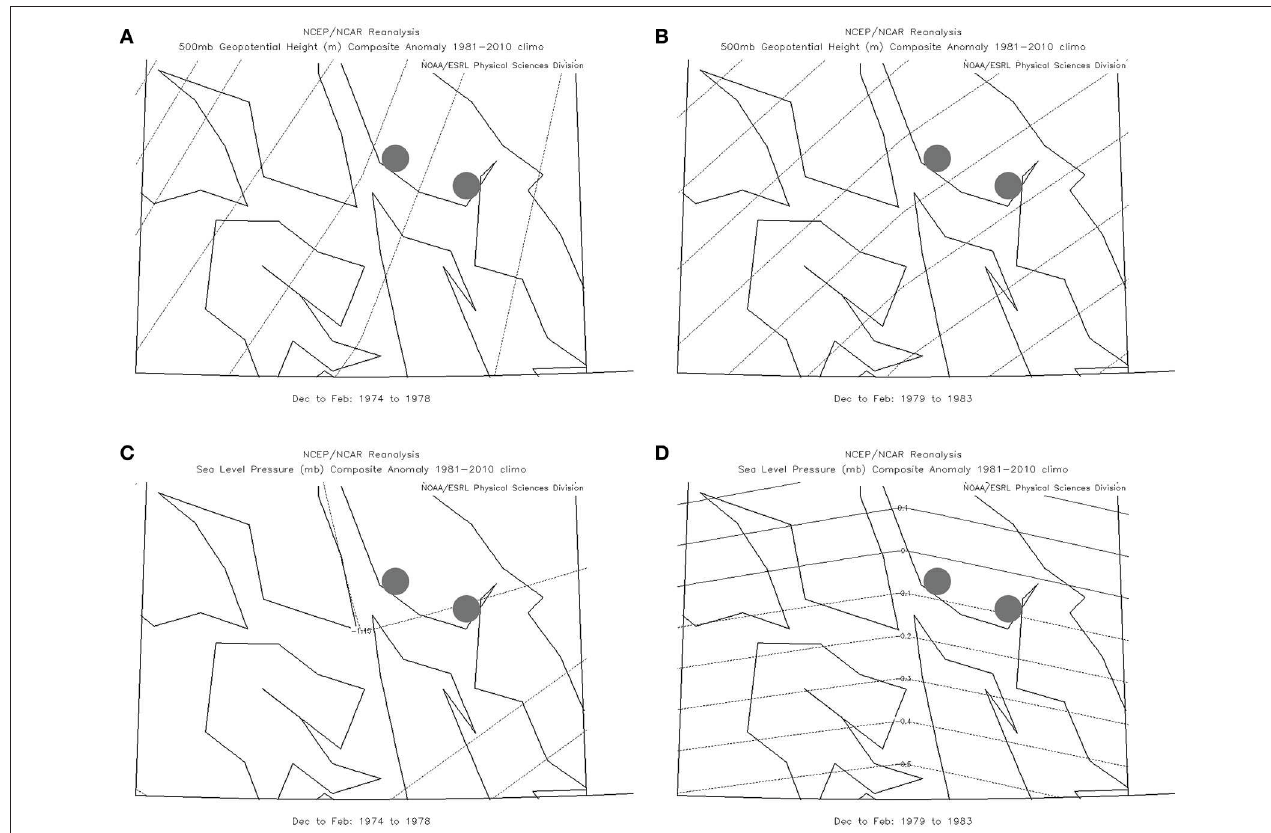
FIGURE 6 | Composite anomaly 500mb geopotential height for southeastern region of Alaska for (A) Five year before change (1974–1978), and (B) Five year after change (1979–1983); composite anomaly Sea Level Pressure (SLP) measured in millibars (mb) for (C) Five year before change (1974–1978), and (D) Five year after change (1979–1983) for southeastern region of Alaska (consisting of stations AB and JIA marked on left and AC on right) for winter months of